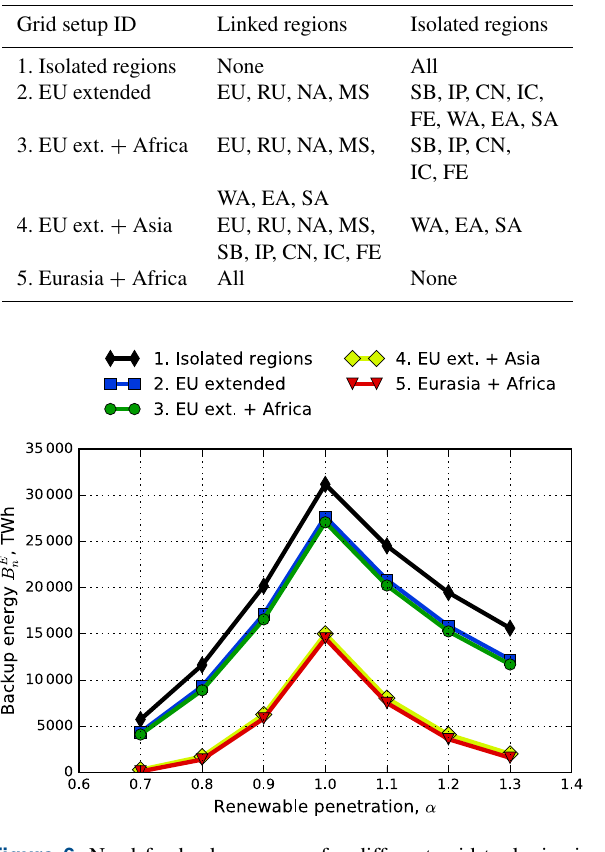
Figure 6. Need for backup energy for different grid toplogies in dependency of the renewable